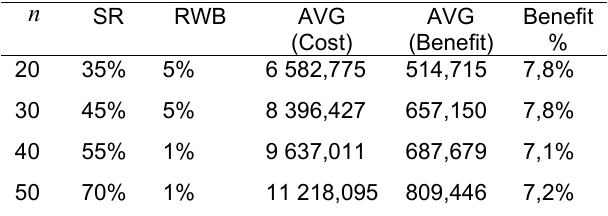
Table 2. Results for 4 N = clusters